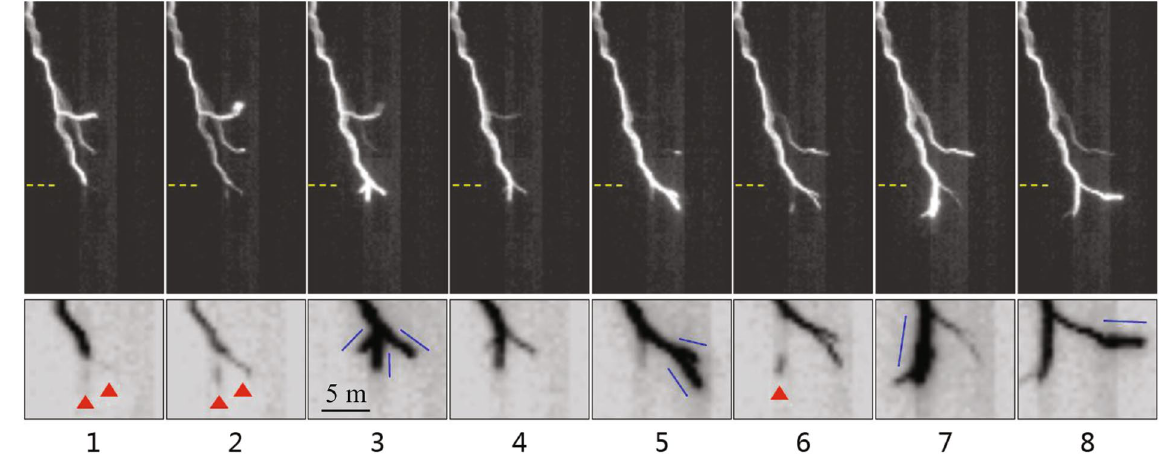
Figure 2. Eight consecutive frames for Flash #1 that reveal the stepped leader evolution. The frames have a 5.56- μ s temporal resolution (obtained at 180,000 fps with exposure time of 5.18 μ s).